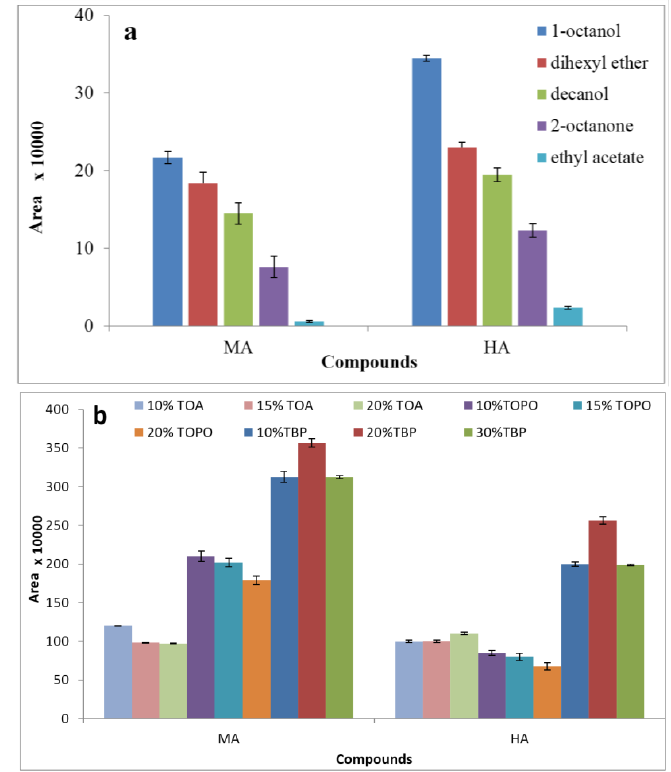
Figure 1. Effects of organic liquid membrane ( a ) and type and amount of carrier ( b ) on the extraction efficiency of hippuric acid (HA) and mandelic acid (MA) by hollow-fiber liquid-phase microextraction (HF-LPME). Extraction condition: 10 mL aqueous sample solution of 1 mg · L − 1 metabolites (pH = 4); 24 µ L acceptor phase sodium carbonate (pH = 10); stirring rate: 800 rpm; donor temperature 25 ◦